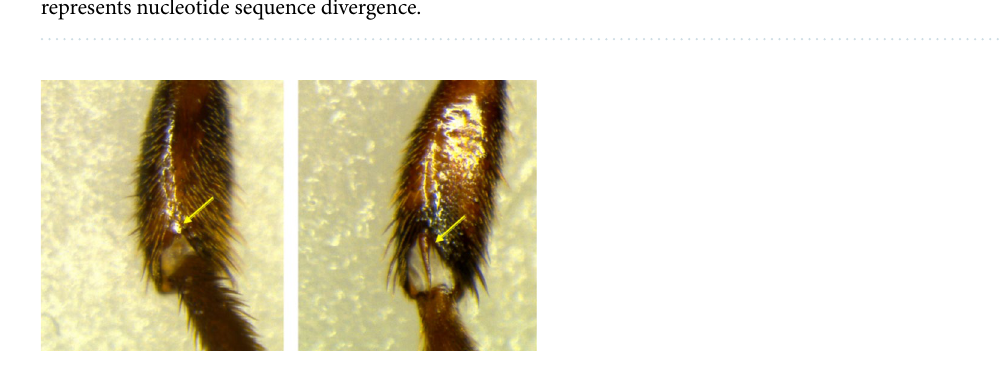
Figure 7. Detail of the tibial spur (pointed with a yellow arrow): minute in L. niitkib (left) and elongated in Lestrimelitta sp. (right), similar to that of L. danuncia